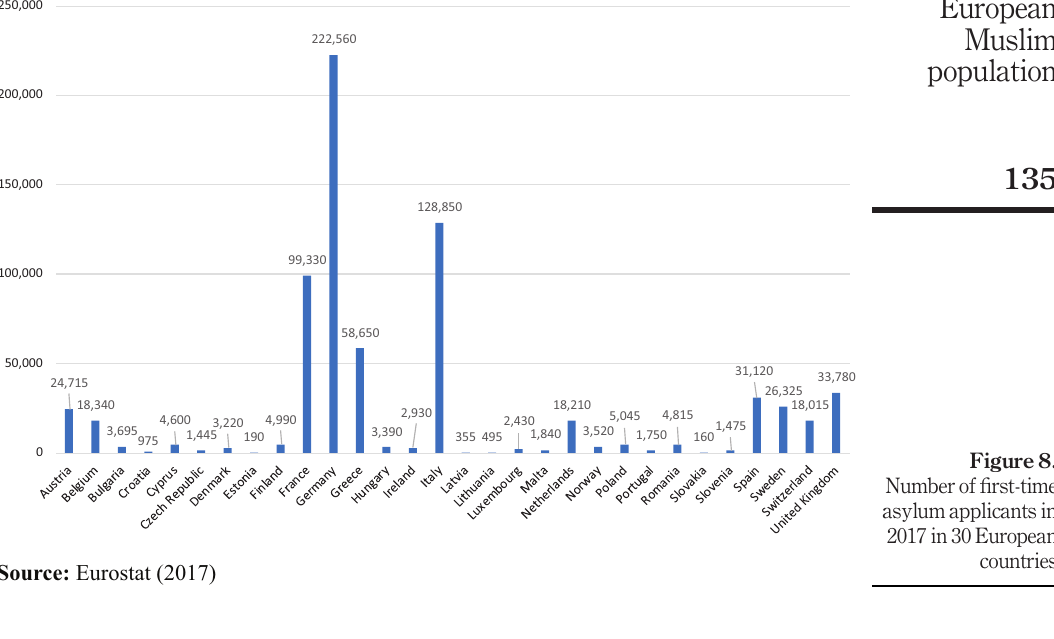
Figure 9. Total number of fi rst time asylum applicants in 30 European countries between 2008 and 2017